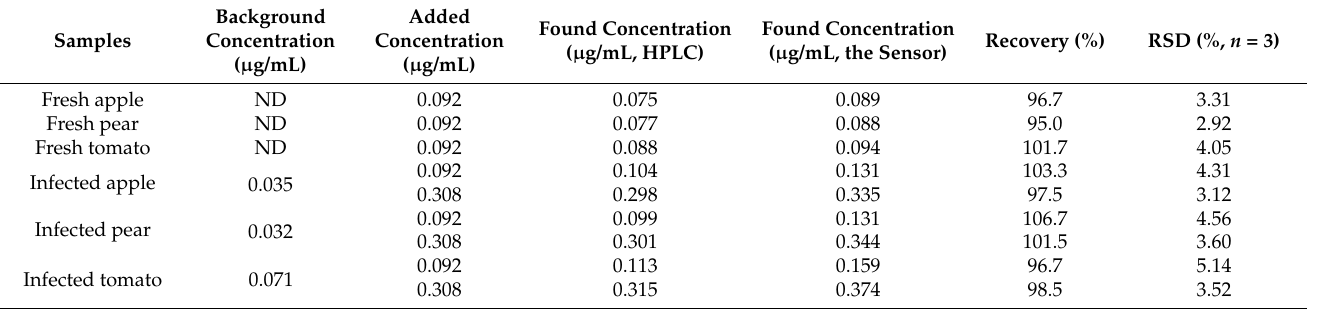
Table 2. Results of the determination of PAT in food samples and recovery tests.